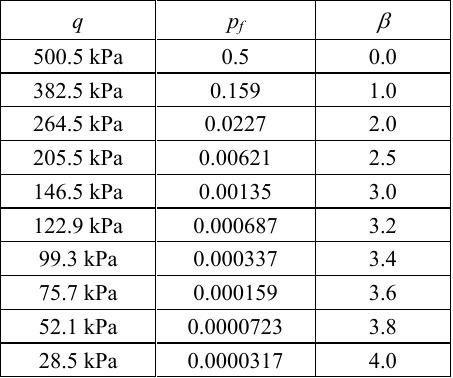
Table 5. Probability of failure and reliability indexes corresponding to certain applied